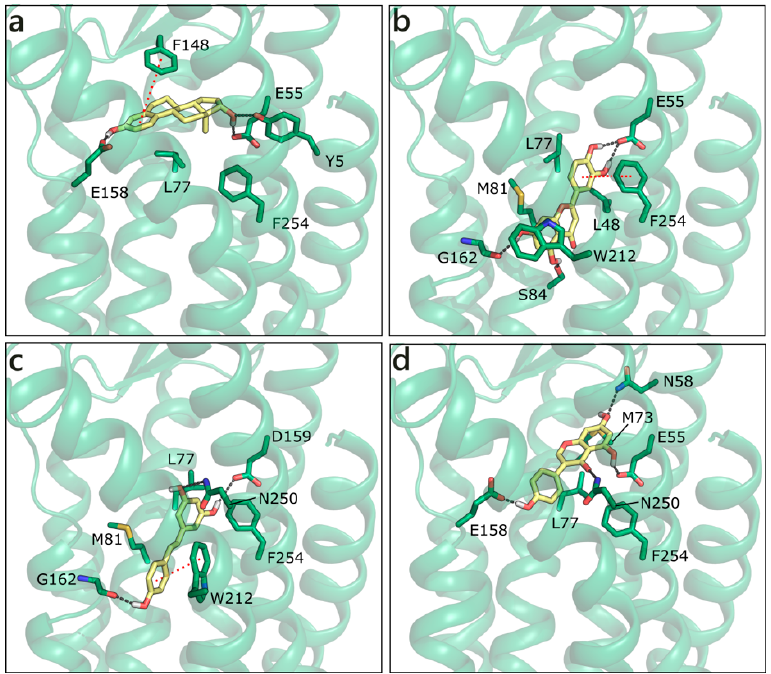
Figure 12. Docking poses of E2 ( a ), LUT ( b ), RESV ( c ), and GEN ( d ) in the G Protein-Coupled Estrogen Receptor (GPER) model. The protein is shown in transparent dark green cartoon, the residues lining the binding site and the ligands are shown in capped sticks and colored dark green and yellow, respectively. Helices and residues lining the pocket are labelled, hydrogen bonds are displayed as black dashed lines.